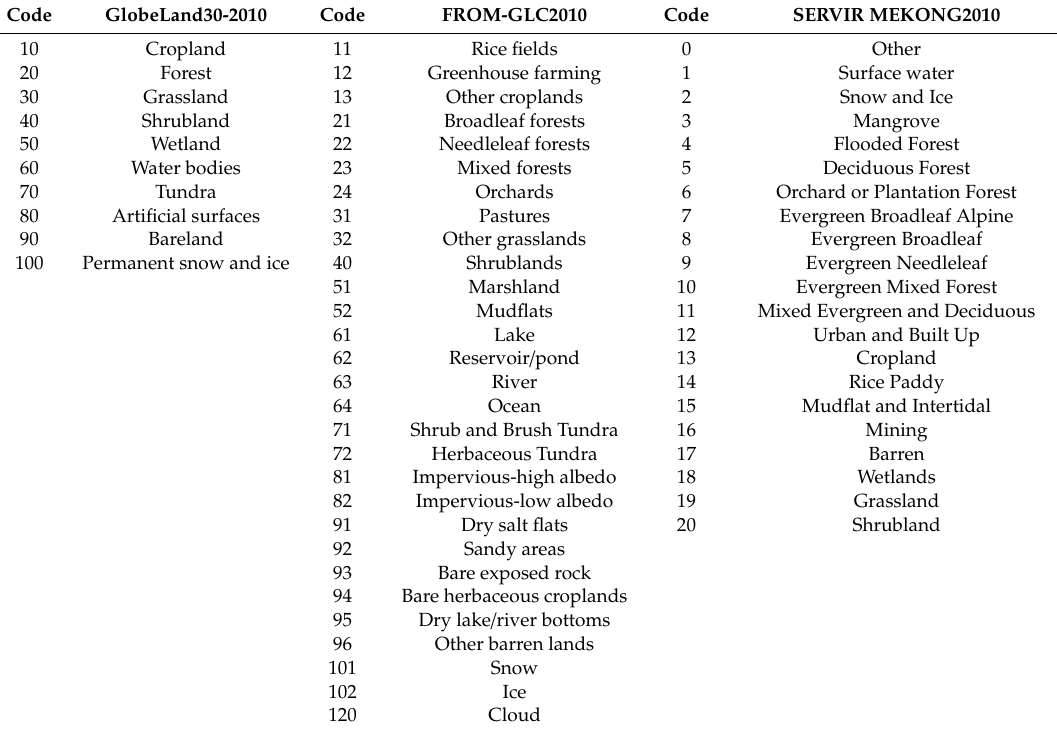
Table2. Theoriginalclassificationsystemsofthethreelandcoverdatasets, alongwiththerelevantcodes.